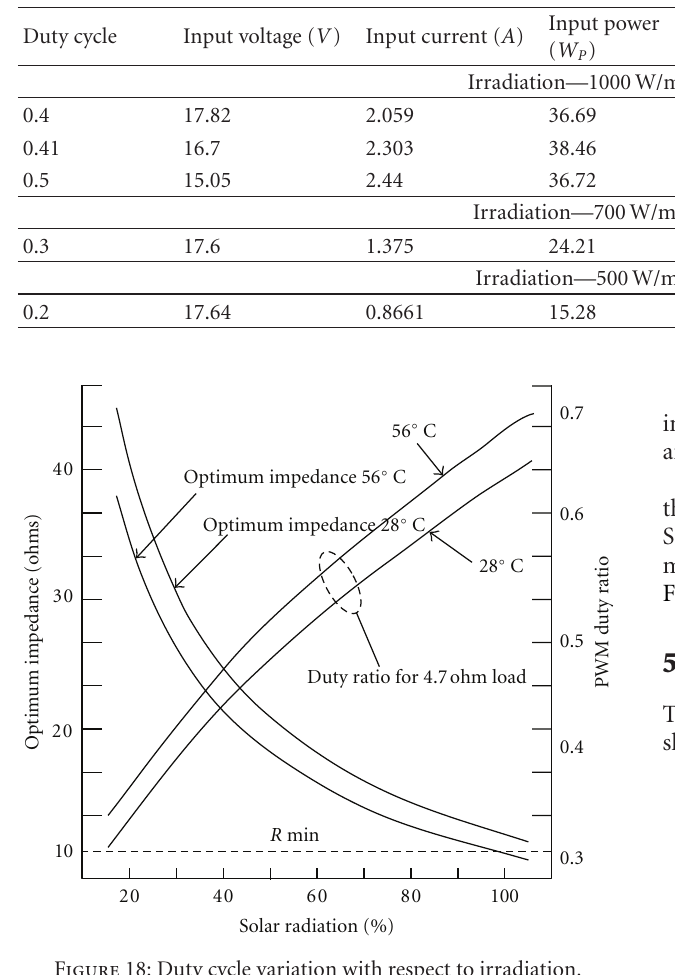
Table 6: Duty cycle variation.